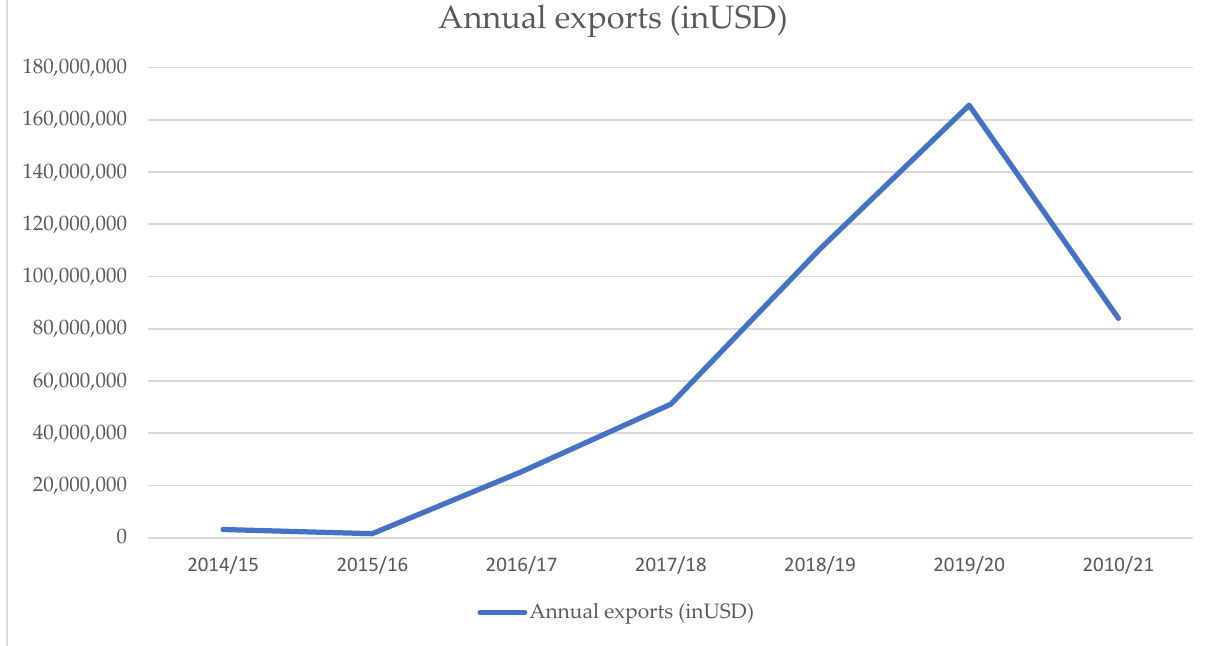
Table 6. IPDC-owned IPs’ job creation